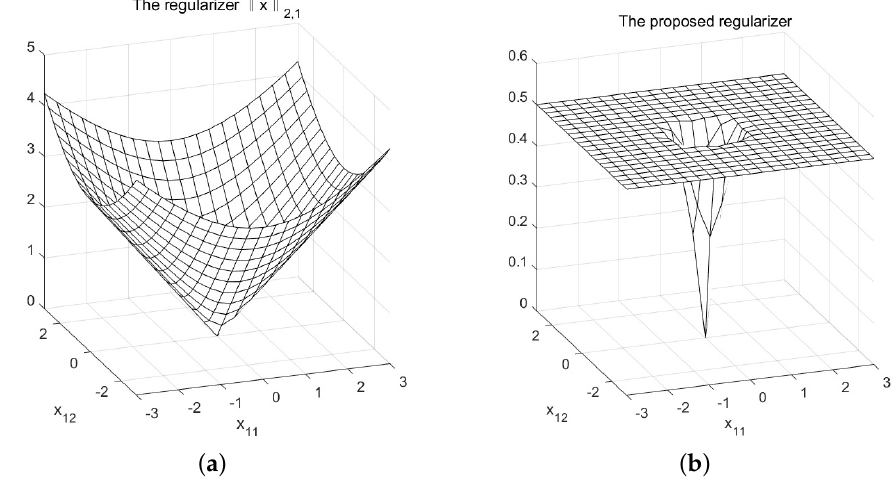
Figure 1. Simple examples of two group sparse regularizers (one group case): ( a ) The (cid:96) 2,1 regularizer; ( b ) The regularizer ( (cid:107) · (cid:107) 2,1 ) I n